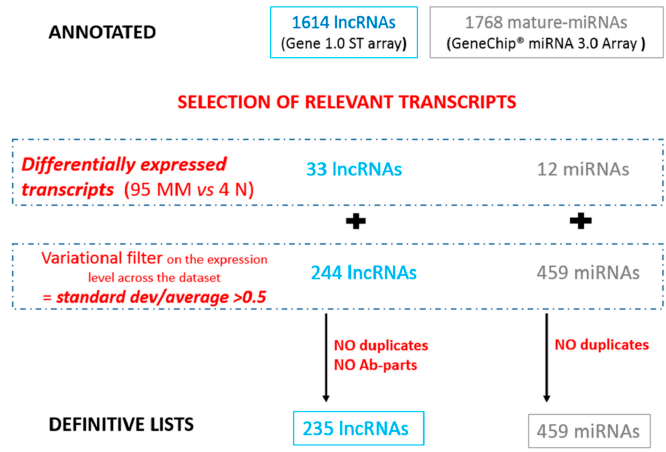
Figure 1. Flow chart used to select relevant lncRNAs and miRNAs for the following analyses.